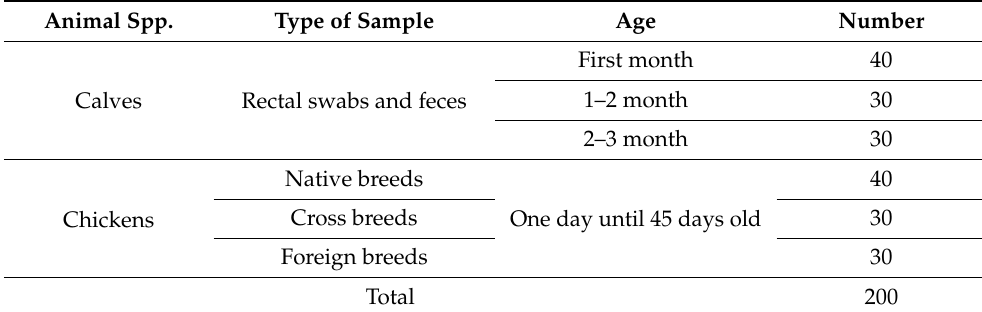
Table 1. Samples taken for Salmonella